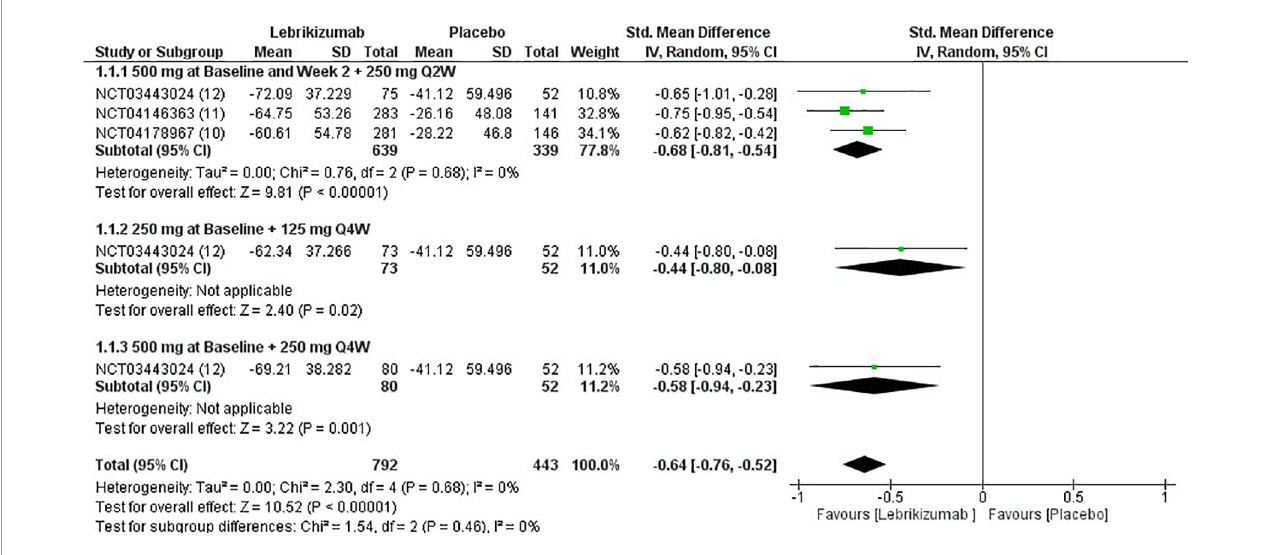
FIGURE4 Forest plot of EASI score. CI, confidence interval; IV, inverse variance; SMD, standardized mean difference; SD, standard deviation; Q2W, every 2 weeks; Q4W, every 4 weeks.